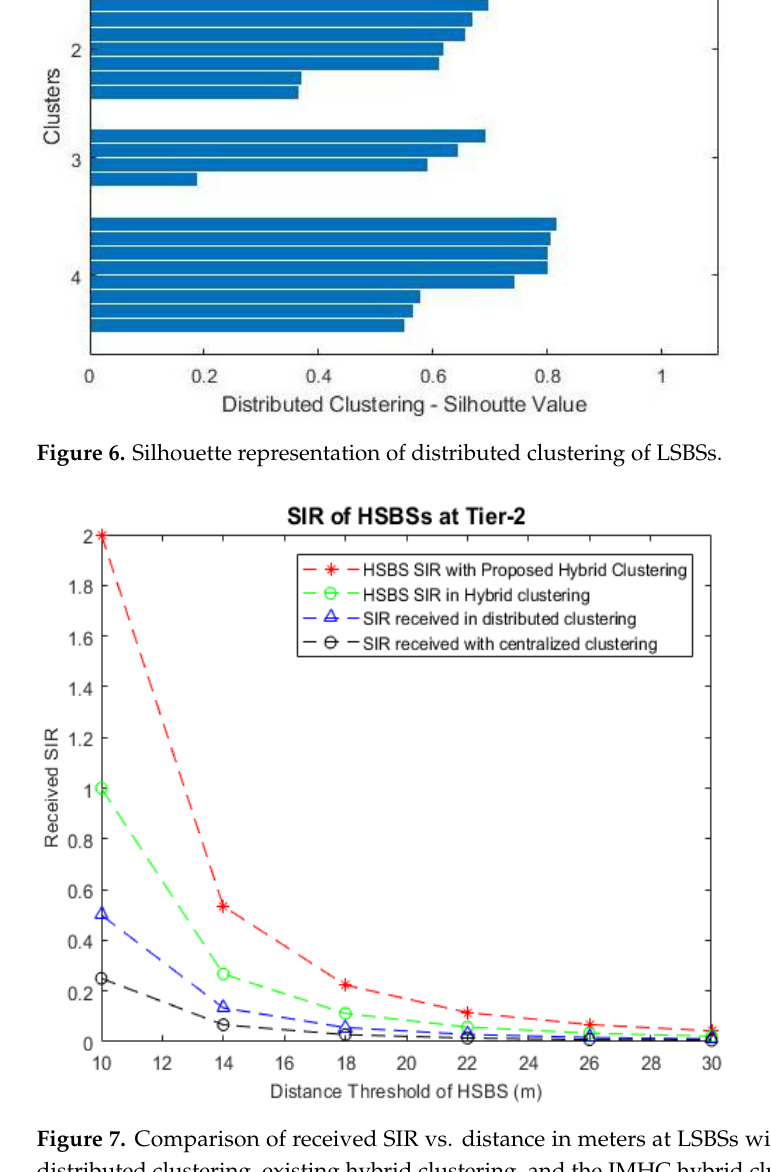
Figure 8. Comparison of received SIR vs. distance in meters at LSBSs with centralized clustering, distributed clustering, existing hybrid clustering, and the IMHC hybrid clustering scheme. Figure 9 shows the overall system throughput achieved after implementing the IMHC hybrid clustering scheme of SBSs, i.e., by increasing the number of SBSs, the achieved system throughput was improved significantly.